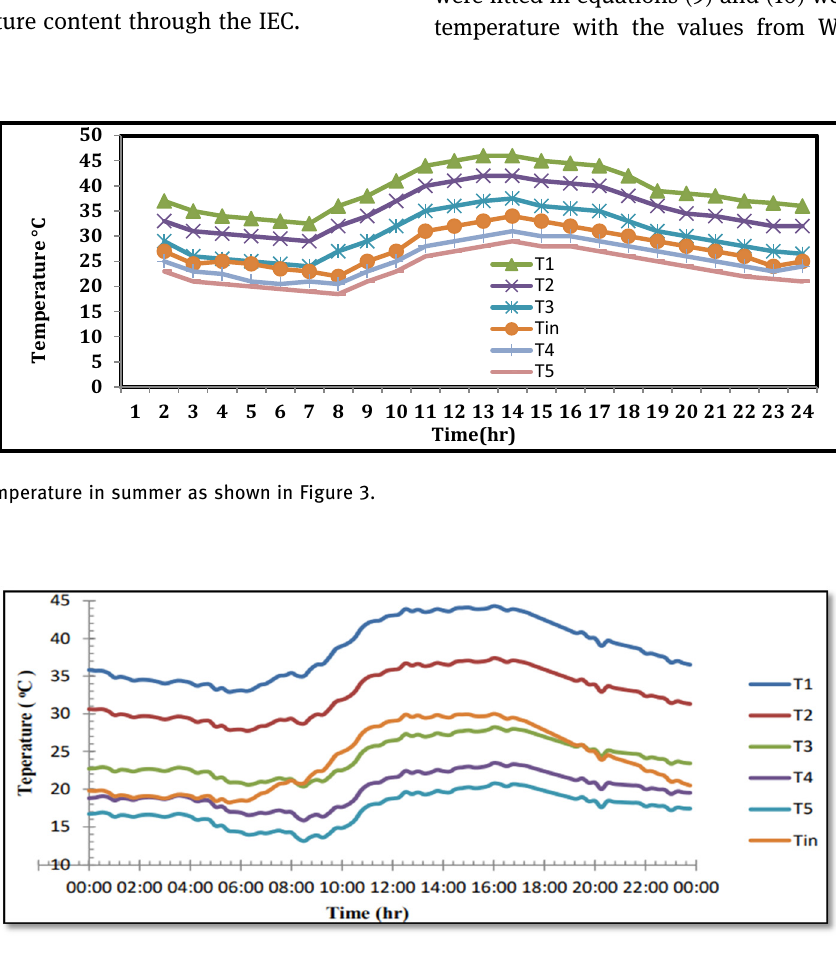
Figure 9: Ambient, process, and inside temperatures of green - house using TRANSYS